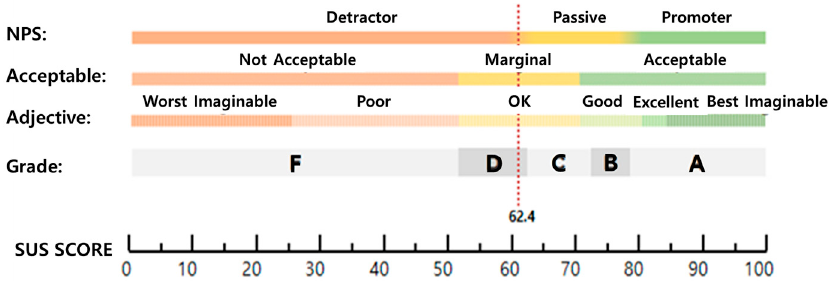
Figure 3. SUS scores and standards.